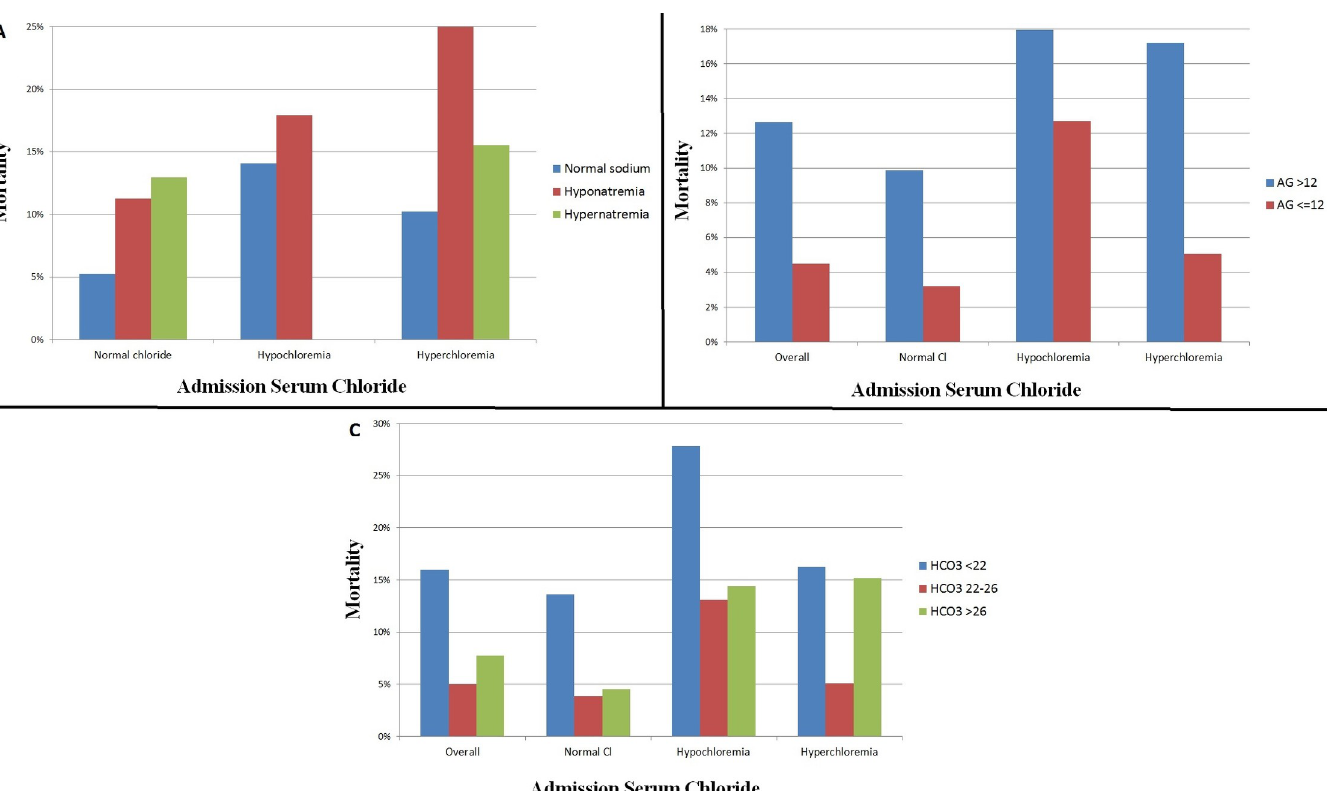
Fig 3. Hospital mortality and admission chloride level in the overall population, based on the admission sodium (A), admission anion gap (B), and acid-base status (C). Hypochloremia is defined as chloride < 98 mEq/L and hyperchloremia is defined as chloride � 108 mEq/L. Hyponatremia is defined as sodium < 135 and hypernatremia is defined as sodium � 145. Metabolic acidosis is defined as bicarbonate < 22 and metabolic alkalosis is defined as bicarbonate > 26.